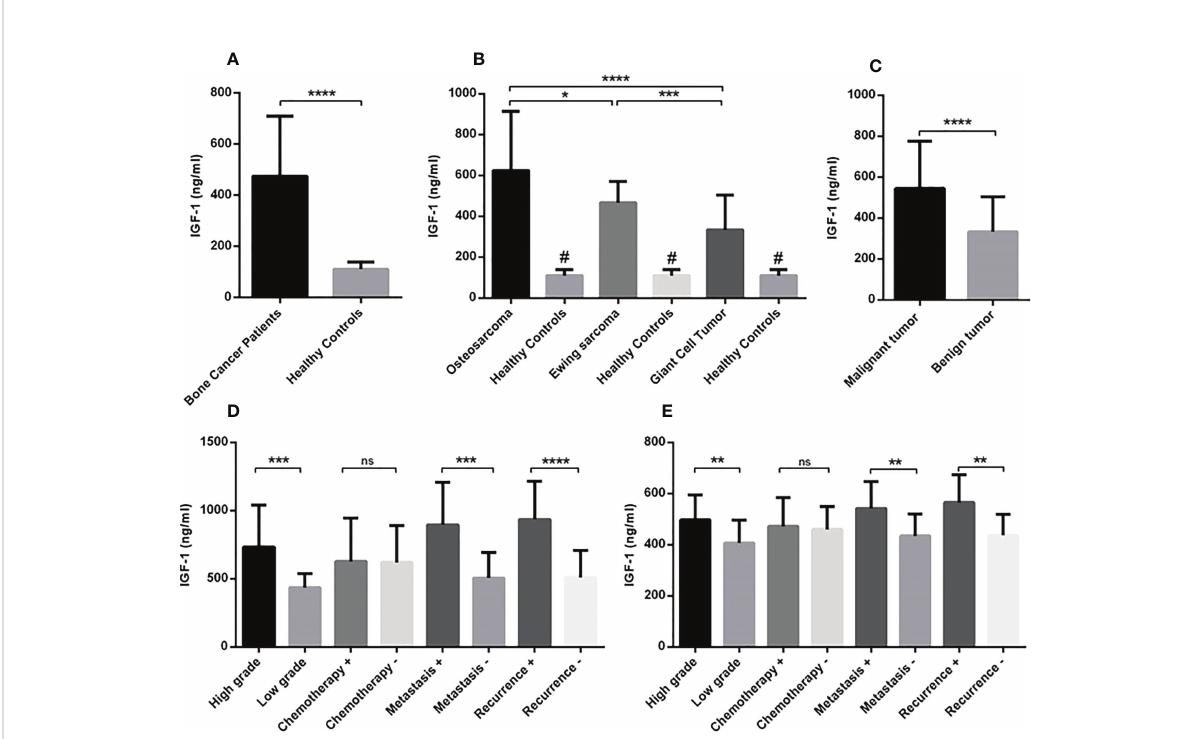
FIGURE 4 The circulating level of IGF-1 in patients with primary bone tumors. The amount of IGF-1 level in the serum of subjects (patients and healthy controls) was detected using ELISA assay. The increased IGF-1 level was detected in patients with bone tumors (N=90) versus healthy controls (N=30) (A) . The osteosarcoma group (N=30) expressed a higher level of IGF-1 compared to the Ewing sarcoma (N=30) and GCT(N=30); while the IGF-1 level was higher in all tumor subtypes compared to the healthy subjects (N=30) (B) . Patients with malignant tumors (N=60) showed more IGF-1 levels (C) and the high-grade (N=19), metastatic (N=9), and recurrent (N=8) osteosarcoma (D) and the high-grade (N=20), metastatic (N=9), and recurrent (N=7) Ewing sarcoma patients showed a higher circulating level of IGF-1 compared to their opposite counterparts. The number of examined samples in each tumor subtype is shown in Supplementary Table 1. The statistical differences between groups are shown as asterisks (*P < 0.05, **P <0.01, ***P <0.001, ****P<0.0001), and (ns) indicates unspeci fi c. (#) indicates P<0.0001 for comparing osteosarcoma, Ewing sarcoma, and GCT with healthy